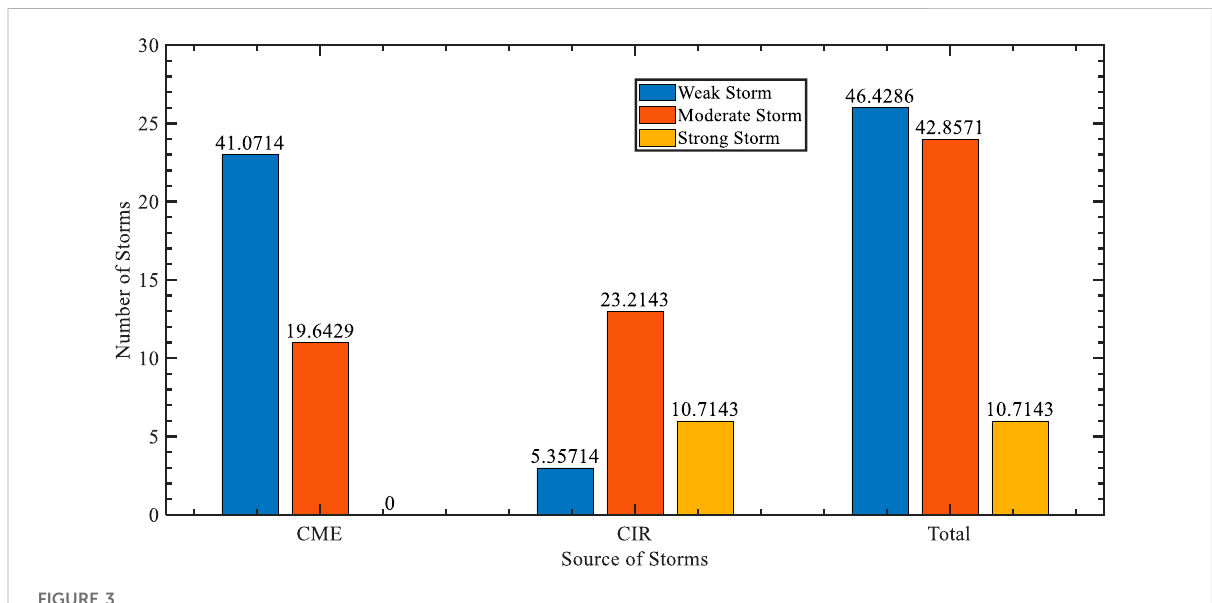
FIGURE 3 Graph of number of storms against storm sources, summarizing the storm classi fi cation in terms of strength of all Dst ≤ − 30 nT for the period between January 2012 and December 2012. The numerical values on the tips of the bars represent the percentages over the overall number of storms.